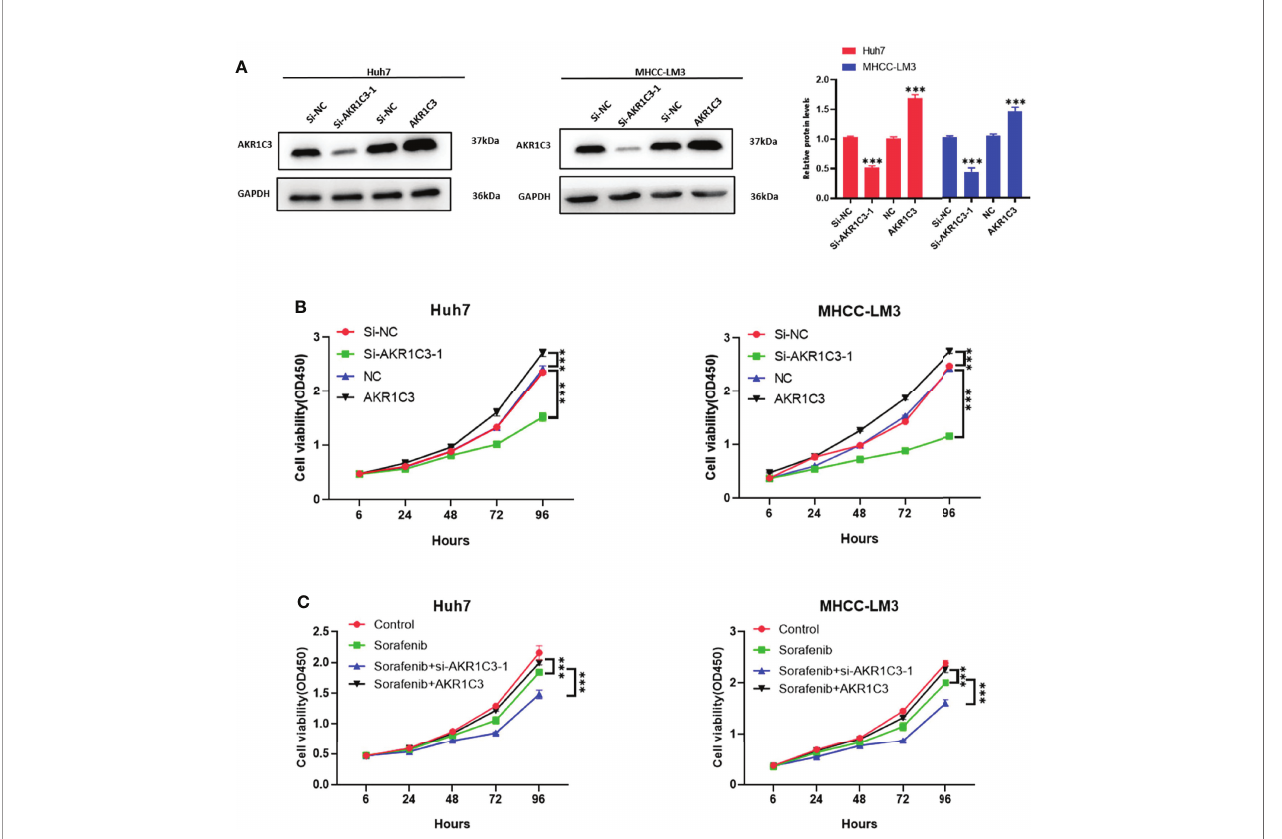
FIGURE 10 | (A) Western blot analysis to examine the ef fi ciency of the AKR1C3 knockdown and overexpression. (B, C) Proliferation curves were determined in AKR1C3 knockdown and overexpression Huh7 and MHCC-LM3 cells by cell counting kit-8 (CCK-8) assays in normal culture conditions and sorafenib sensitivity experiment. Data were shown as mean ± SD of at least three independent experiments. (***p < 0.001).